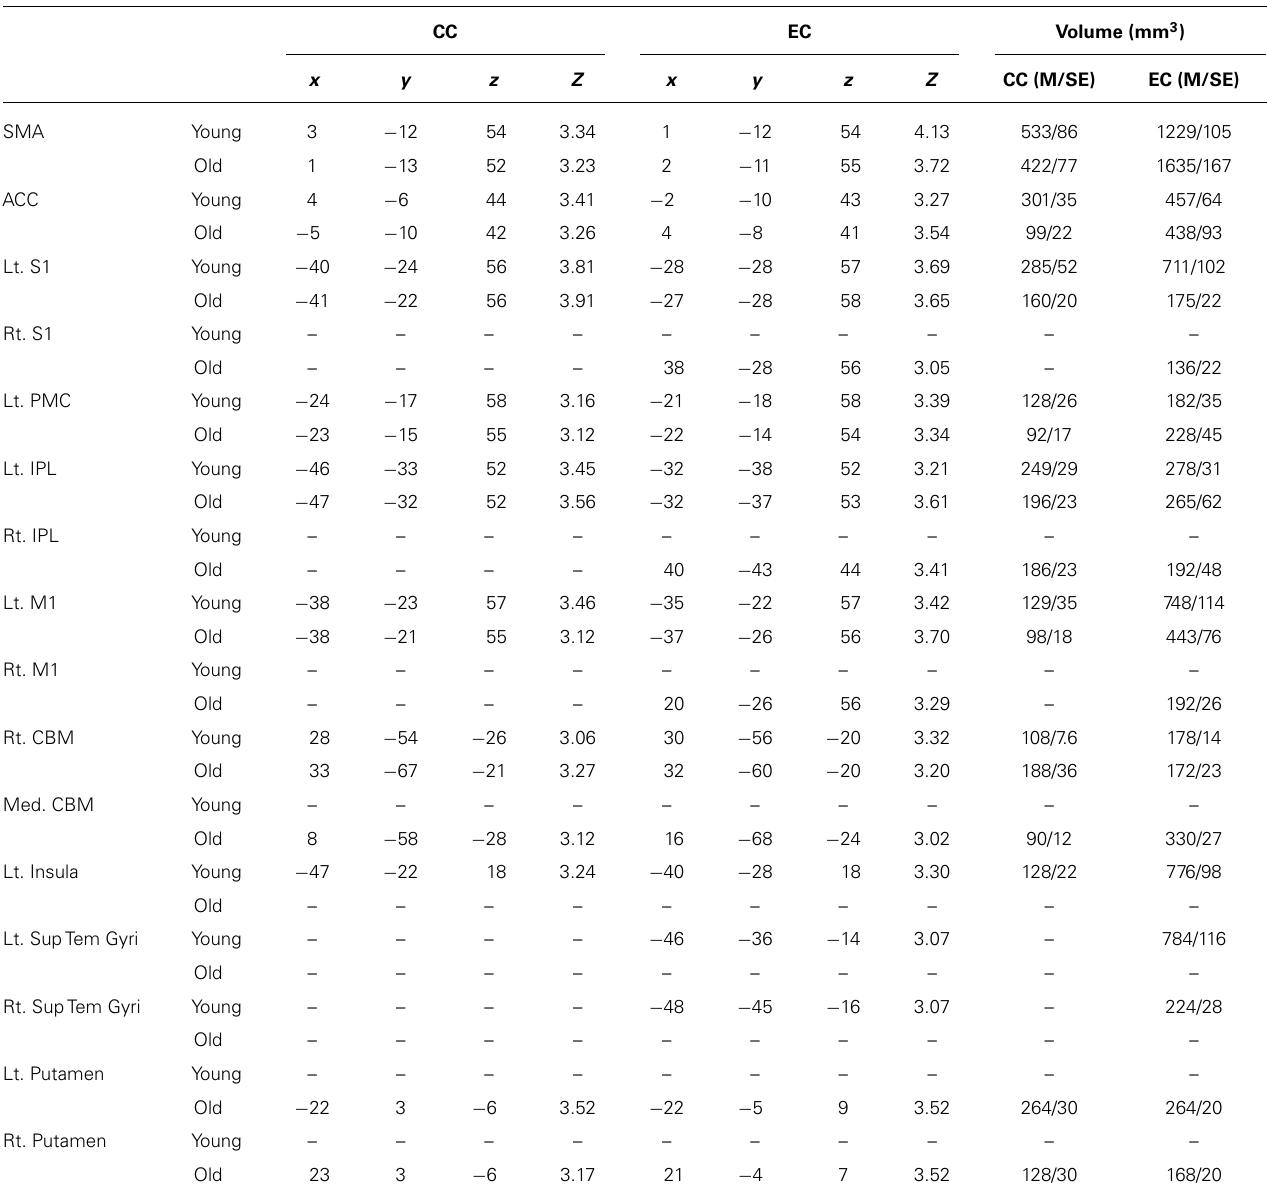
Table 1 |The volume of brain areas activated during CC and